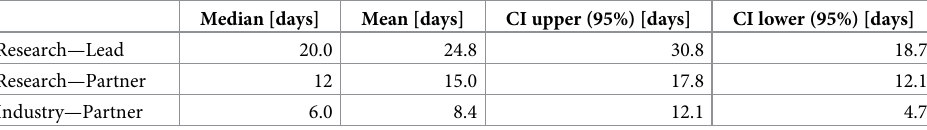
Table 5. Aggregated data: Medians, Means and 95% confidence intervals. Median [days] Mean [days] CI upper (95%) [days] CI lower (95%) [days]